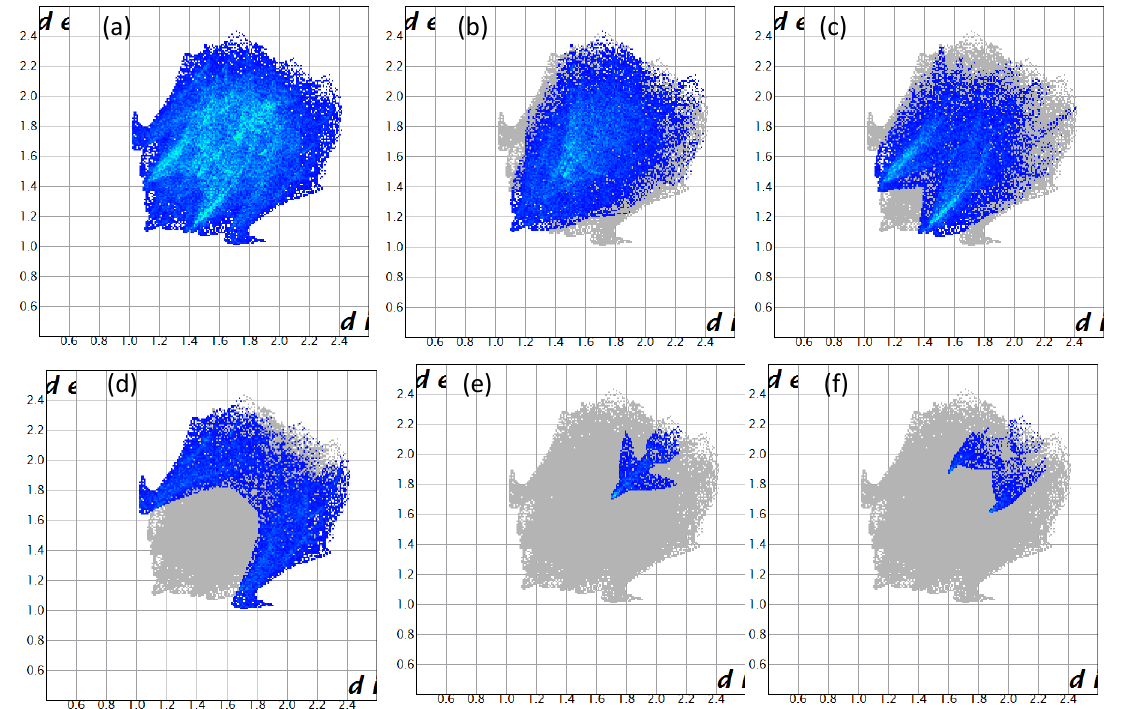
Figure 7. Hirshfeld surface of 3 mapped with d norm , showing potential hydrogen bond (dashed lines).